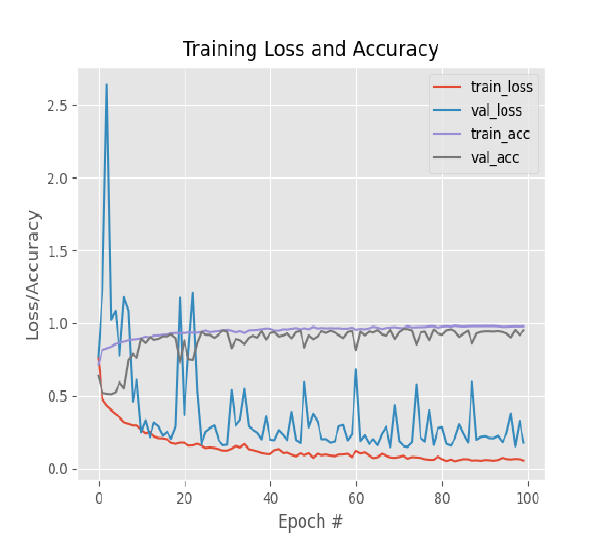
Figure 7. Loss Accuracy Graph on